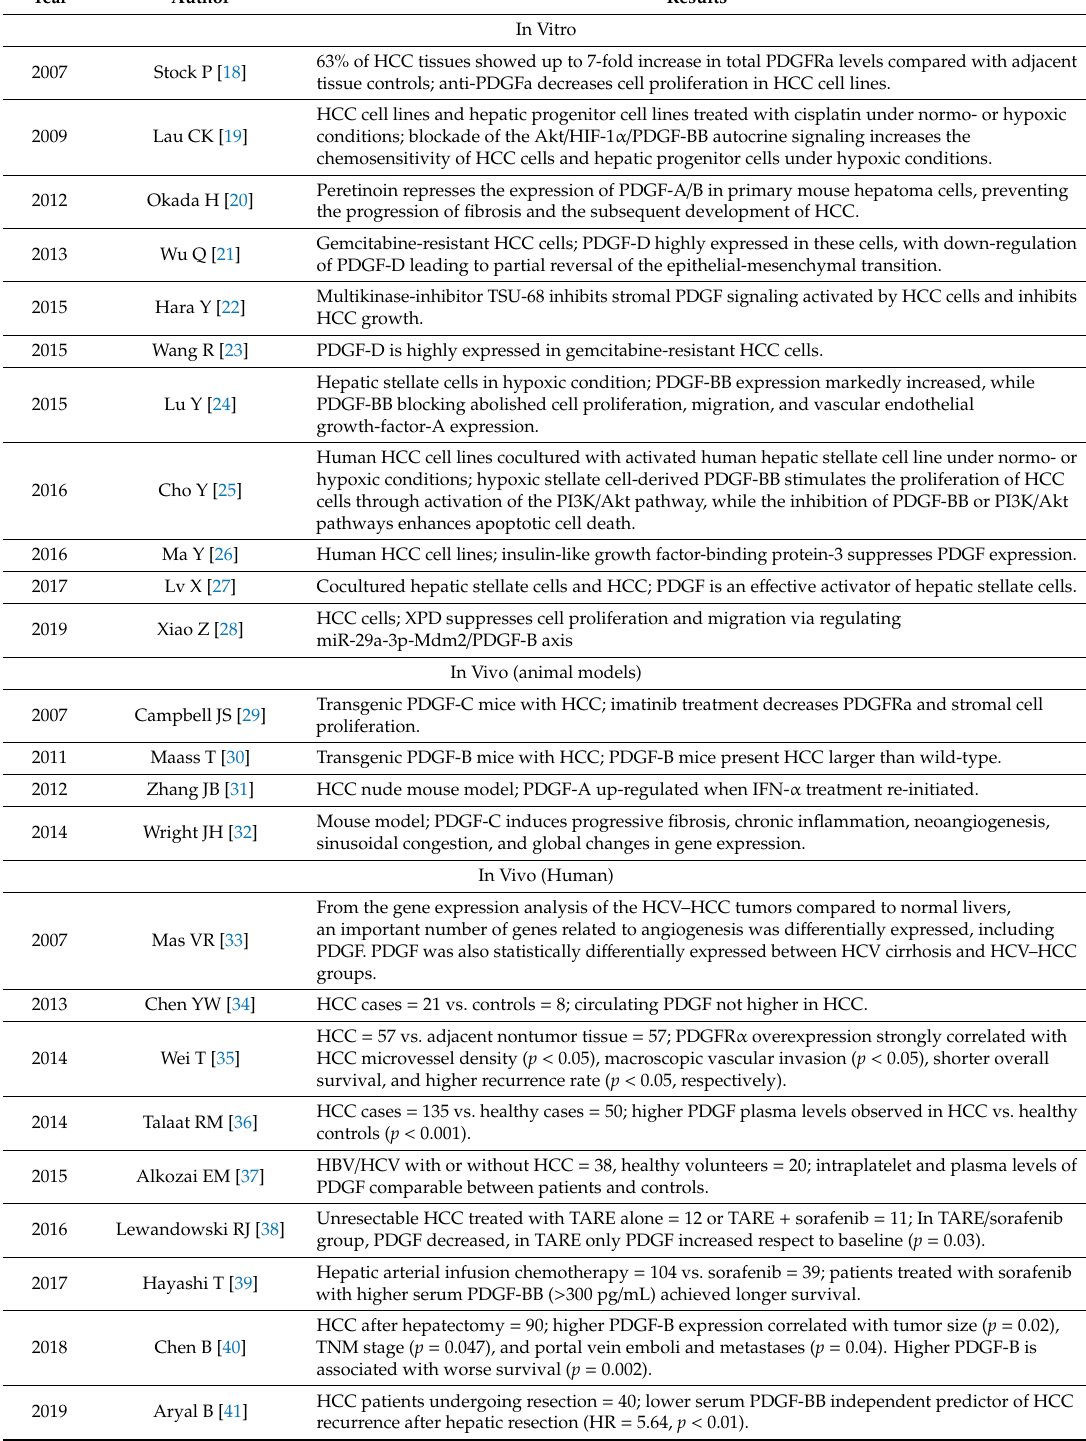
Table 1. Studies focused on the role of platelet-derived growth factor in the development of HCC.